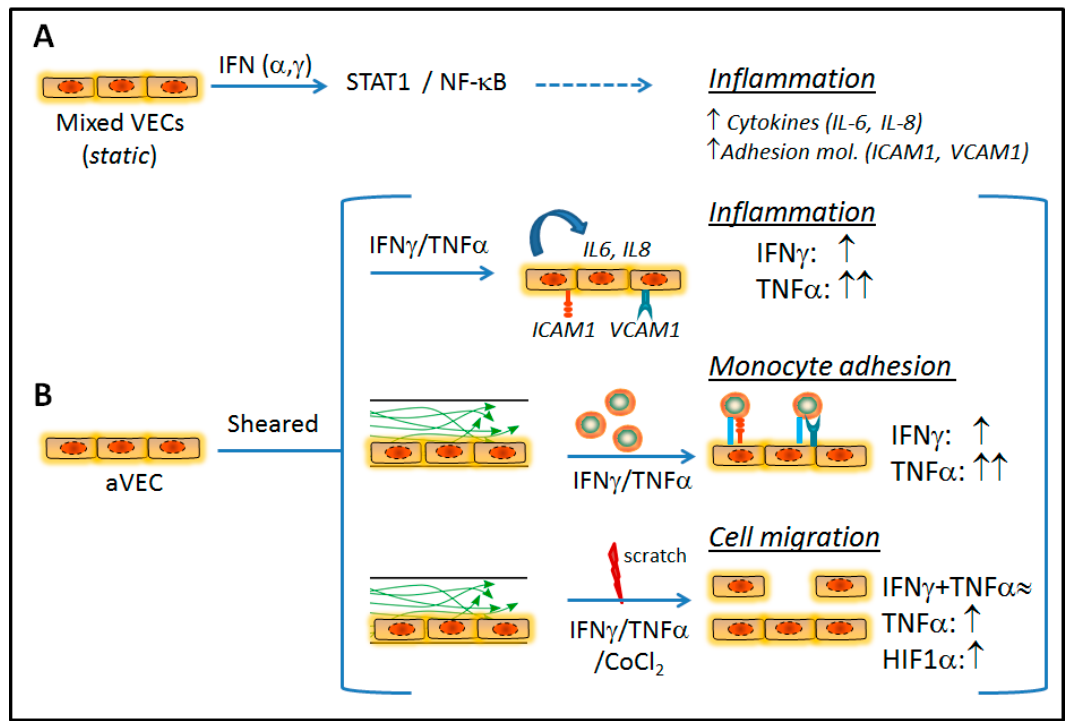
Figure 8. Schema depicting the effects of IFN in shear-stressed site specific VEC. ( A ) In mixed VEC under static conditions, IFN promotes a pro-inflammatory phenotype characterized by the induction of STAT1 and NF- κ B routes and subsequent inflammatory molecules. ( B ) Exposure of sheared side-specific VEC to cytokines (IFN- γ , TNF- α ) promotes inflammation. Moreover, aVEC were more prone to cytokine-mediated monocyte adhesion under multiaxial flow conditions. Finally, TNF- α and a chemical inducer of HIF-1 α (CoCl 2 ) promoted migratory effects, while IFN- γ reduced TNF- α –mediated effect. Together, data revealed differences between cytokines and flow types.